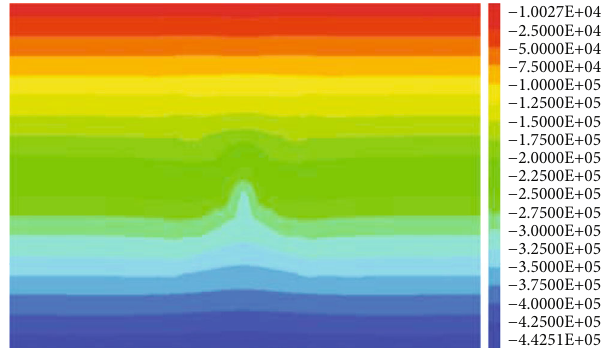
Figure 13: Initial vertical stress